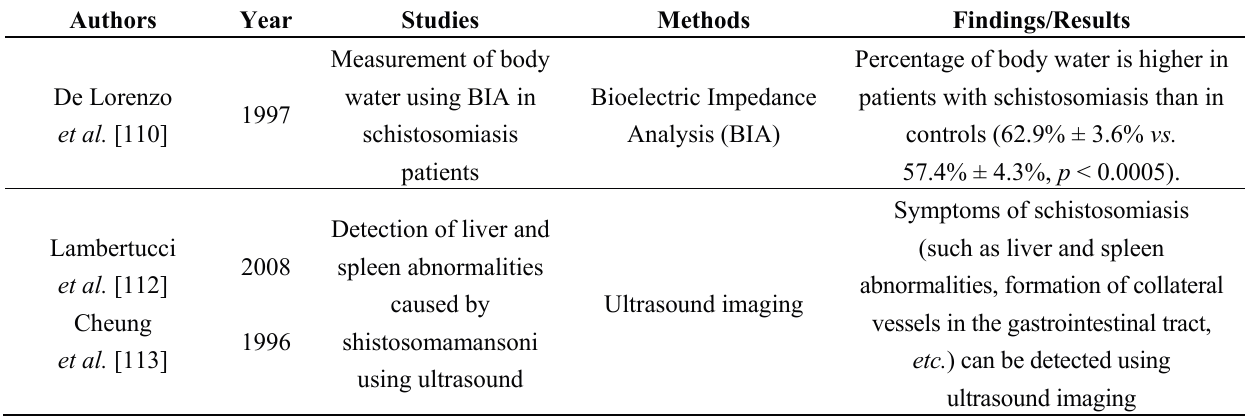
Table 7. Summary of the biomedical engineering techniques in schistosomiasis